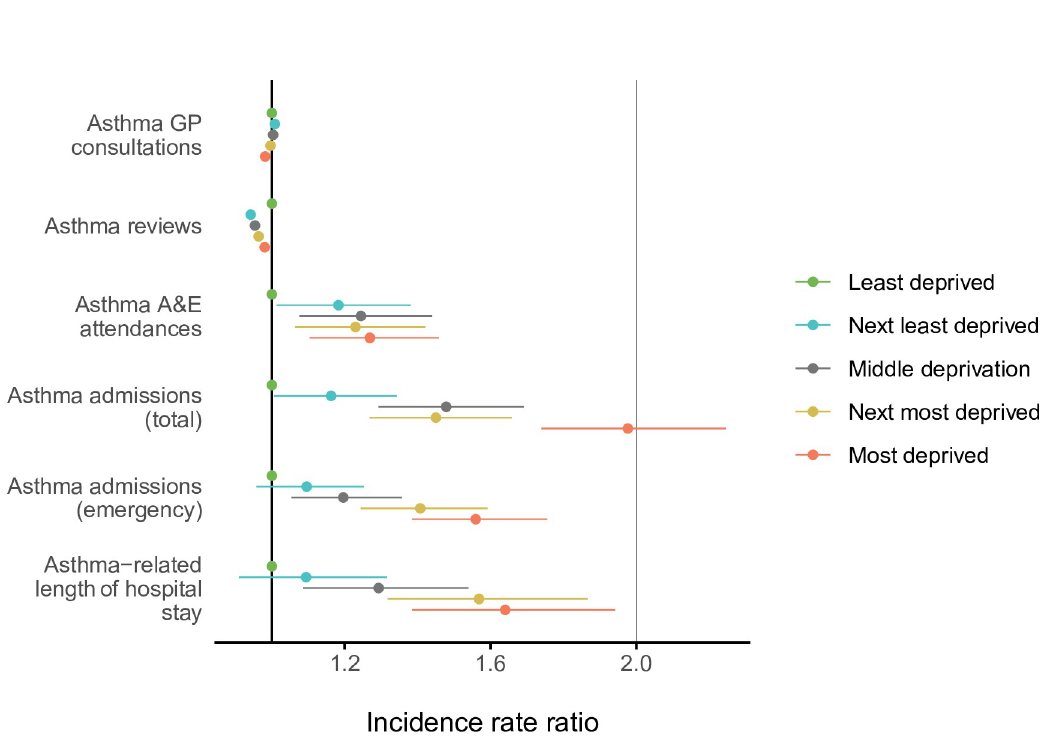
Fig 1. IRRs with 95% CIs of asthma health service utilisation in each of the WIMD 2011 quintiles relative to the least deprived quintile, controlled for age and gender. Note: The CIs for GP consultations and review are extremely narrow and may not be obvious in the plot. A&E, accident and emergency; CI, confidence interval; GP, general practitioner; IRR, incidence rate ratio; WIMD, Welsh Index of Multiple Deprivation.